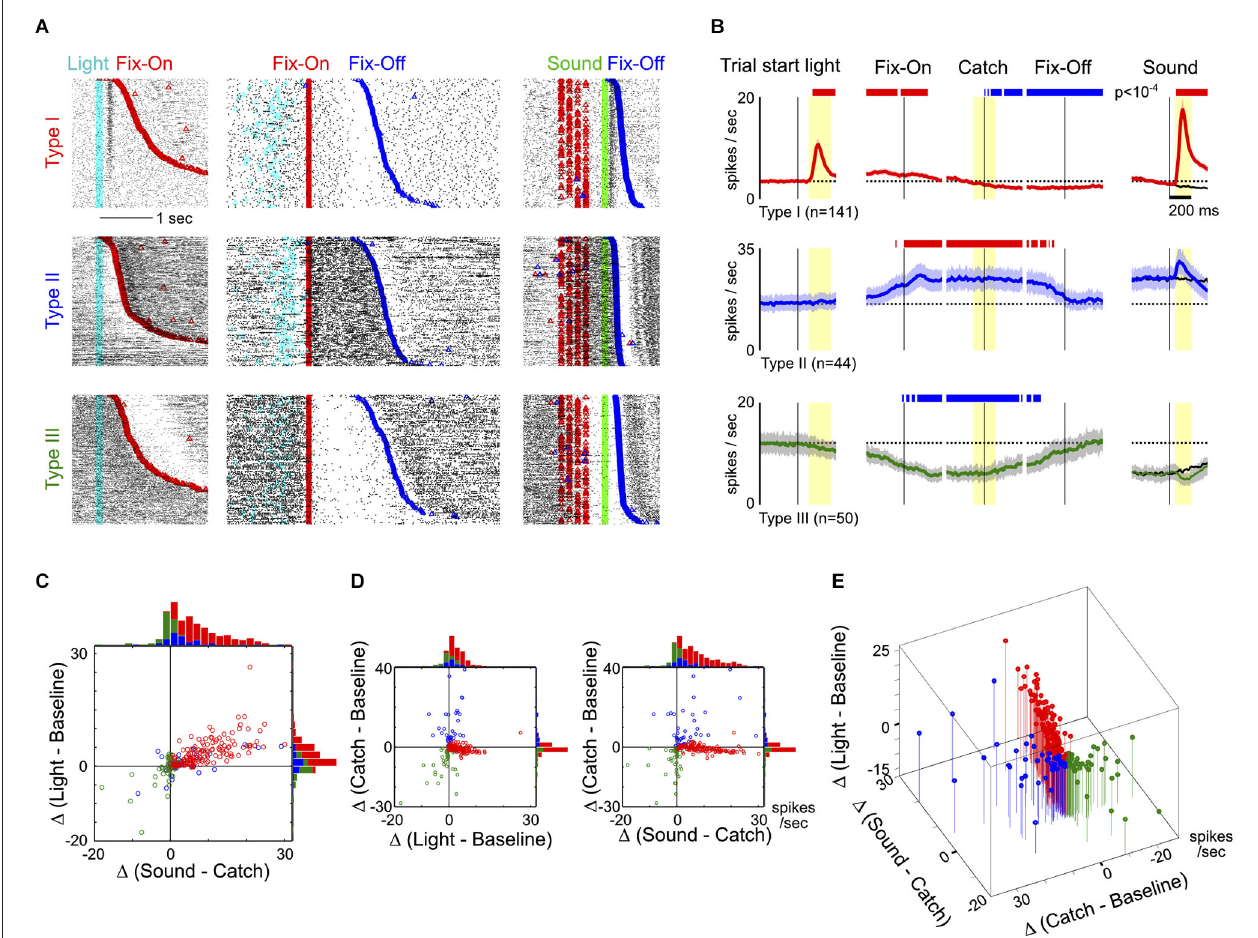
Dashed lines depict the average baseline firing rates for each type of neuron. Significant changes in firing rates are indicated by red (increased rate) and blue (decreased rate) bars. In the left four columns, firing rates are relative to baseline firing rates; in the right column, they are relative to catch trials (paired t -tests, p < 10 − 4 ). (C) Scatter plot of individual neuronal response amplitudes to the trial start light (relative to baseline) vs. sounds (relative to catch stimulus), along with marginal distributions. The time windows for response amplitude calculation are indicated by yellow shaded areas in (B) . There was substantial overlap between Type-I and II neurons. (D) Scatter plots of individual neuronal response amplitudes between light vs. catch stimulus and sound vs. catch stimulus. Conventions are the same as in (C) . (E) The three features combined separates the three main types of BF